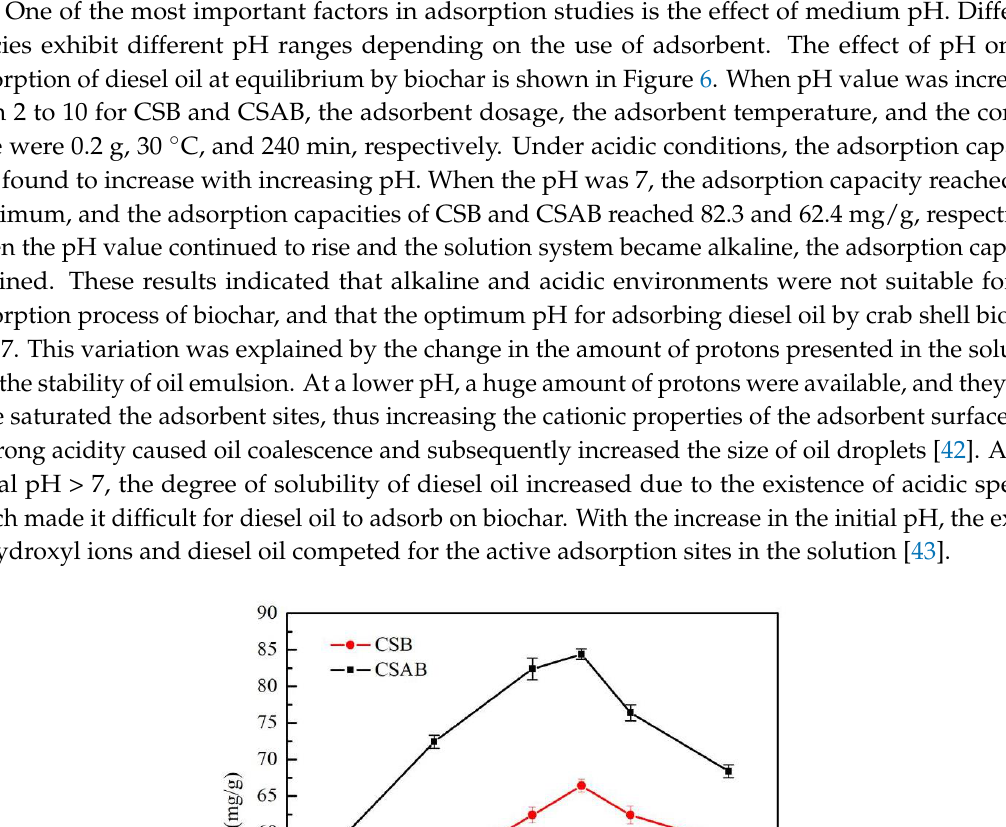
Figure 7. Effect of temperature on adsorption of diesel oil onto biochar. 3.5. Effect of Contact Time Figure 8 shows the adsorption capacity of biochar versus contact time. Experiments were performed at an adsorbent dosage of 0.2 g, a pH value of 7, and a temperature of 30 °C with different contact times that ranged from 10 to 360 min. As can be seen from Figure 8, the amount of diesel oil adsorbed on biochar increased with time. At a certain time point, it reached a constant value beyond which the diesel oil could not be further removed from the solution. At this point, the amount of diesel oil from activated carbon and the amount of diesel oil adsorbed on biochar were in a state of